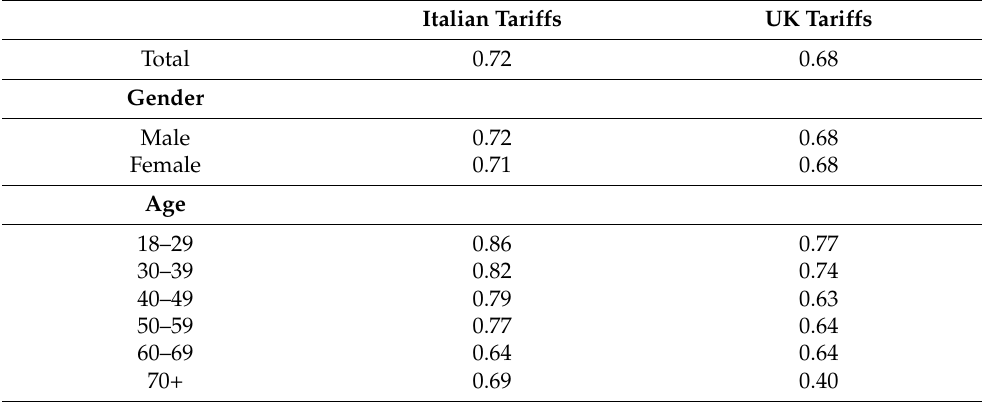
Table 4. Results of the health-related quality of life (HR-QoL) scores in our cohort of patients with Fabry